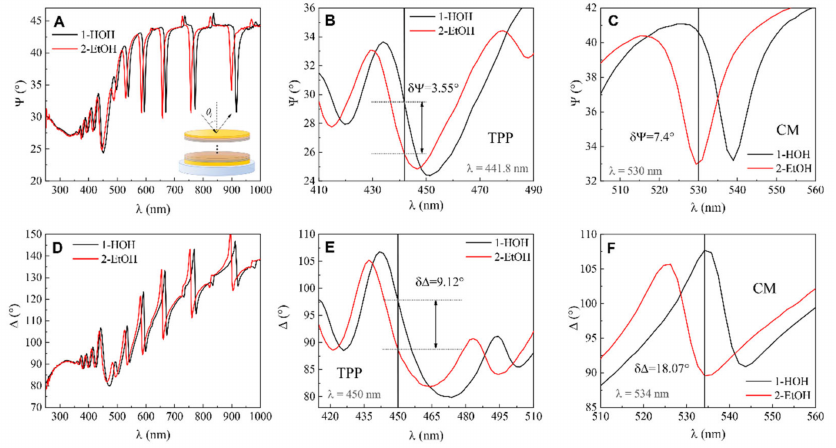
Figure 5. ( A ) Ellipsometric parameter Ψ dependence on wavelength λ for (1) mQCM-D in water- filled cell, (2) QCM-D/TPP in ethanol-filled cell, and zoomed view of A for TPP ( B ) and CM ( C ) components. ( D ) Ellipsometric parameter ∆ dependence on wavelength λ for (1) QCM-D/TPP in water-filled cell, (2) QCM-D/TPP in ethanol-filled cell, and zoomed view of D for TPP ( E ) and CM ( F )